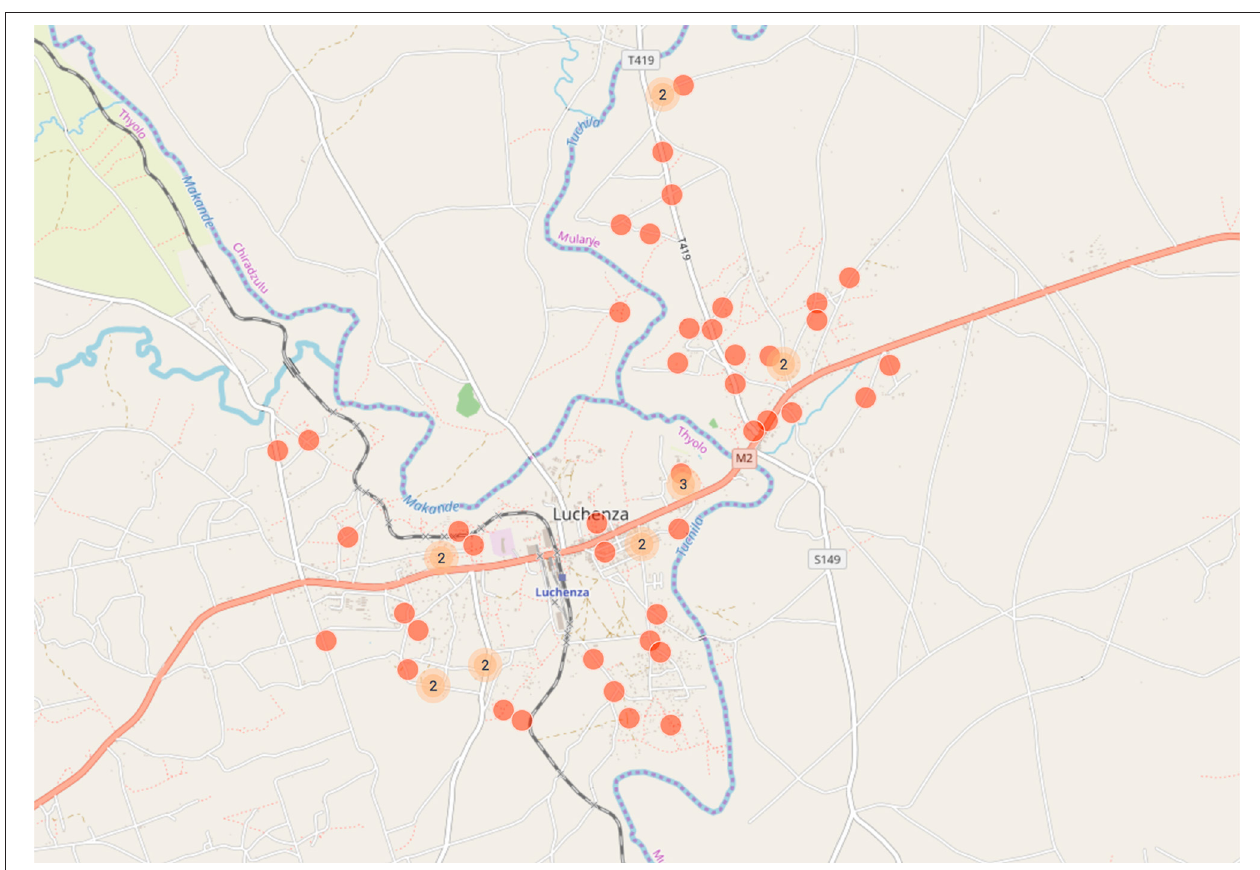
FIGURE 5 | Water points of